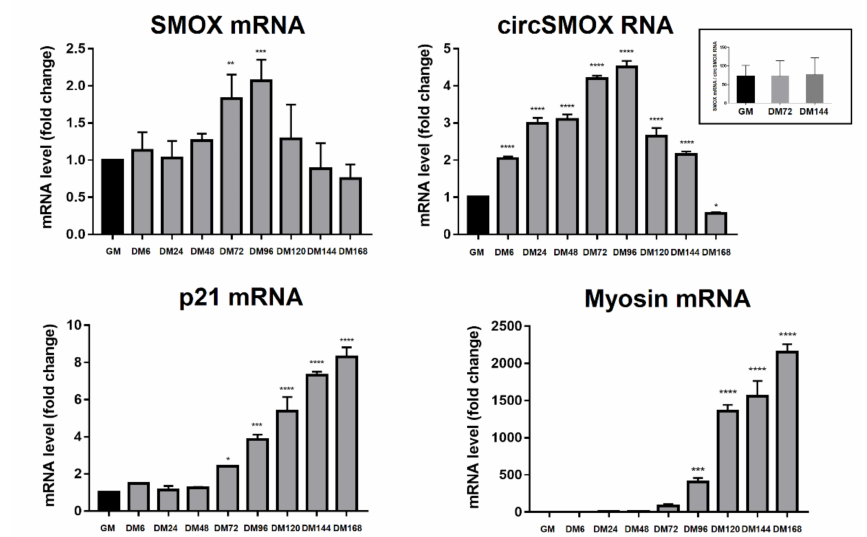
Figure 2. RNA transcript expression during C2C12 cell di ff erentiation. qRT-PCR of linear SMOX, circSMOX, p21 and myosin RNAs amplified from C2C12 myoblasts (GM) and myotubes (DM)